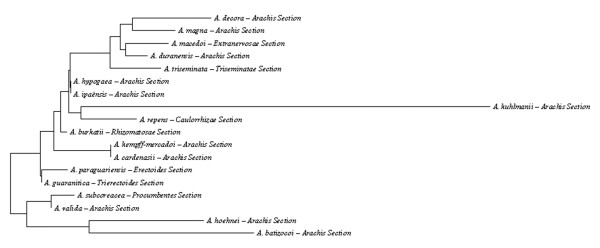
Relationships among A. hypogaea and 17 Arachis (A. valida, A. triseminata, A. subcoreacea, A. cardenasii, A. guaranitica, A. batizocoi, A. repens, A. duranensis, A. paraguariensis, A. burkartii, A. ipaënsis, A. kuhlmanni, A. kempff-mercadoi, A. magna, A. hoehnei, A. decora, A. macedoi) species based on polymorphism found in the sequences amplified using primer pair Ah11.